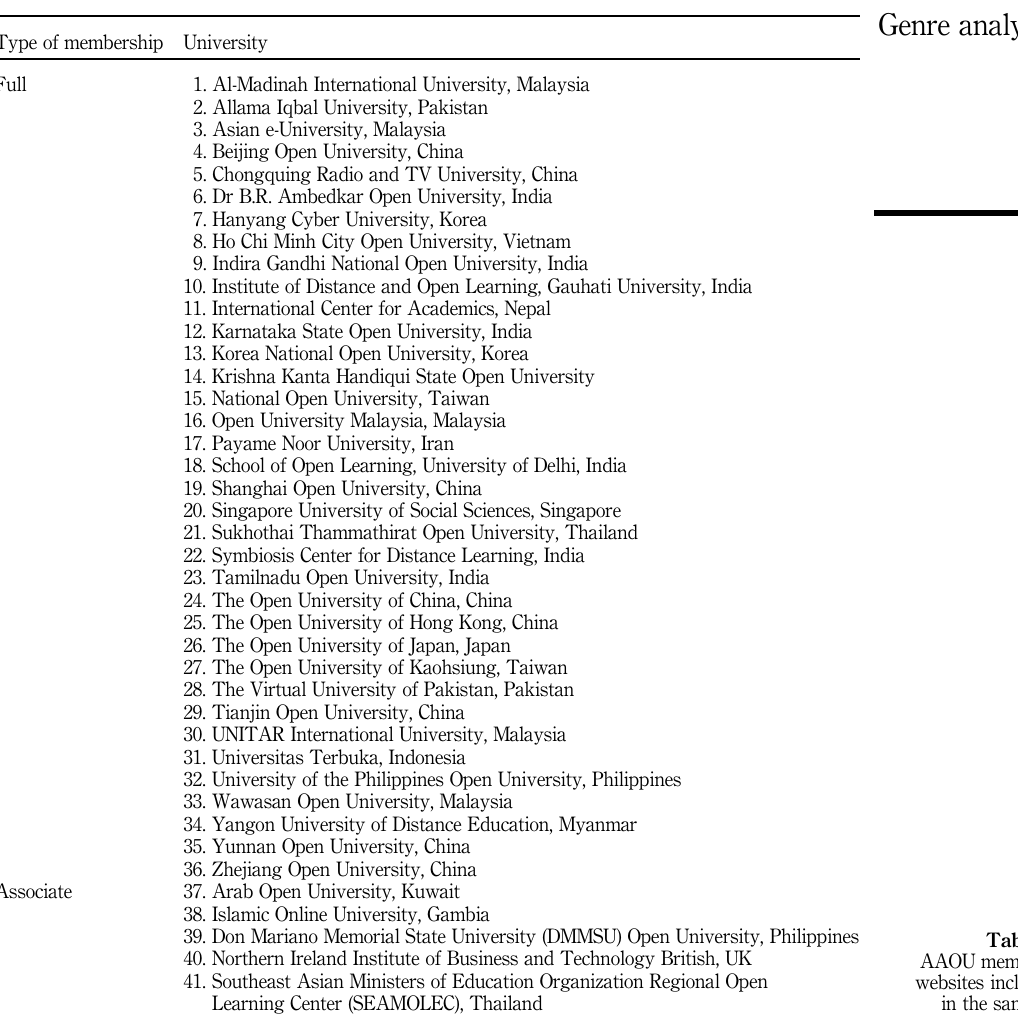
Table I. AAOU members ’ websites included in the